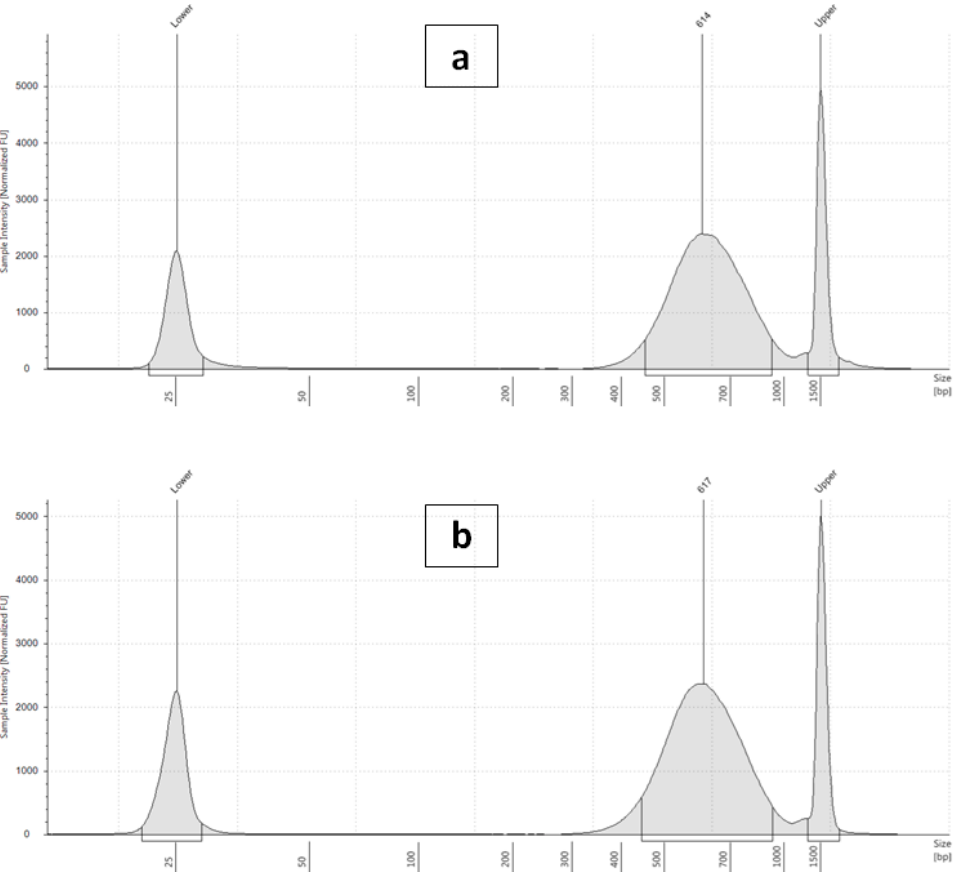
Figure 4. Quality check electropherogram of post-library construction on the Agilent 2200 TapeStation ( a ) Reseda lutea and ( b ) Reseda pentagyna . Table 3. Summary statistics for Reseda lutea and Reseda pentagyna genome sequences.